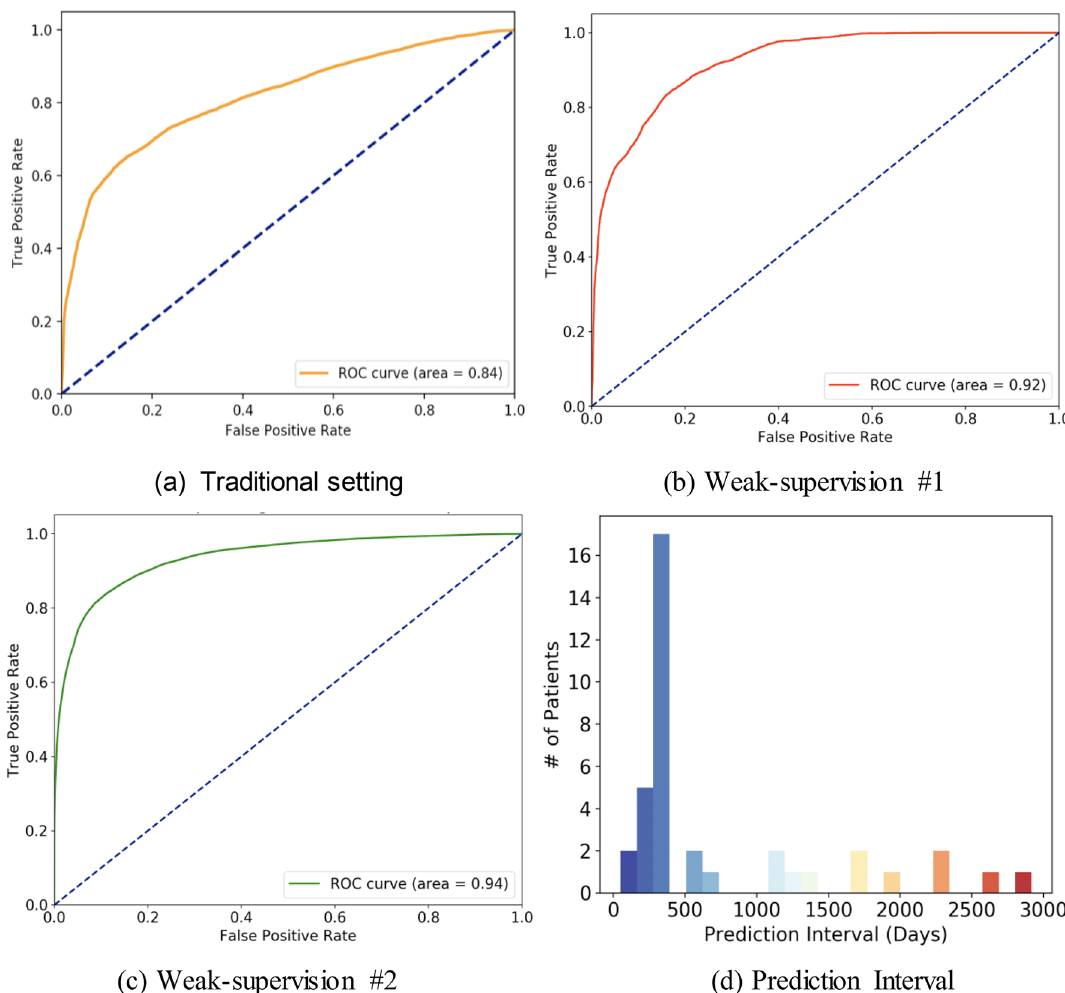
Figure 3. LTSM model performance evaluated as Receiver Operating Characteristic curves trained with ( a ) 670 manually curated patients, ( b ) weak supervision combining manually curated (670 patients) and NLP generated labels of 7437 patients, ( c ) weak supervision combining manually curated (670 patients) and NLP generated labels of 7437 patients with more positives samples. ( d ) The distribution of prediction interval (time between positive recurrence prediction and actual recurrence) for patients in the test cohort using the best performing LSTM model.